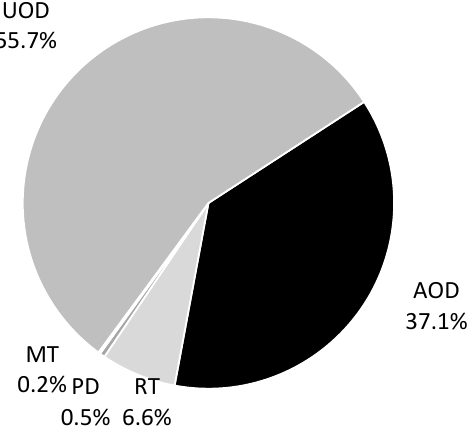
Figure 3. Share of unavoidable operational delays (UOD), avoidable operational delays (AOD), repair times (RT), personal delays (PD) and maintenance times (MT) among total delay